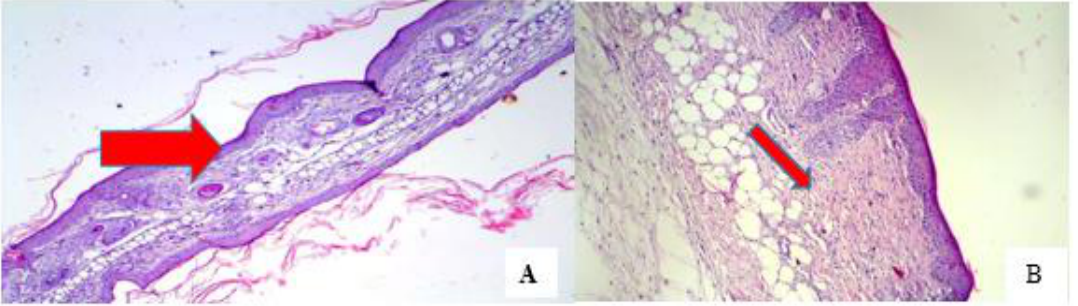
Figure 2. ( H and E ) staining sections of the mouse back area skin and ear skin of vehicle susp+IMQ group (200X) A: section of back area skin B: section of right ear vehicle susp+IMQ group showed slight acanthosis of stratified epithelium more than 6 cells with an increase of rete ridge. Red arrows : sign to the thickness of the epidermal layer of back area and right ear section.